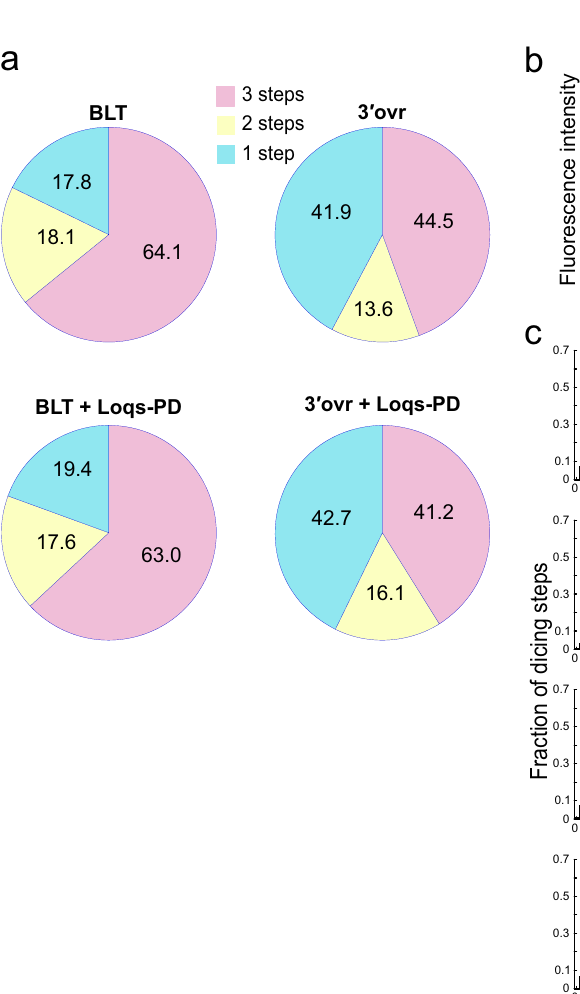
Fig. 2 Single-molecule analysis of the dsRNA cleavage reaction by Dcr-2 tethered on the glass. a Schematic representation of the Dcr-2-anchored single-molecule observation. b – e Representative single-molecule images of surface-tethered Dcr-2 and co-localized dsRNAs (wild-type and BLT [ b n = 9 independent experiments], wild-type and 3 ′ ovr [ c , n = 20 independent experiments], the G31R helicase mutant and BLT [ d n = 2 independent experiments], and the G31R helicase mutant and 3 ′ ovr [ e , n = 2 independent experiments]). Co-localized spots were indicated by yellow circles. dsRNAs were frequently co-localized with wild-type Dcr-2, but rarely with the helicase mutant. Scale bar, 2 μ m; inset. f – h Representative traces of the “ 3-steps ” ( f ), “ 2-steps ” ( g ), and “ 1-step ” ( h ) events. The x axis shows the time after starting the observation. i Representative trace of 3× Cy3-labeled BLT dsRNAs co-localized with the RNase III mutant. Three repetitive PIFE events were observed without cleavage. j Binding rate of dsRNAs, calculated from the total number of binding events (3-steps, 2-steps, and 1-step). BLT dsRNAs bind Dcr-2 more frequently than 3 ′ ovr dsRNAs. Loqs-PD enhances the binding